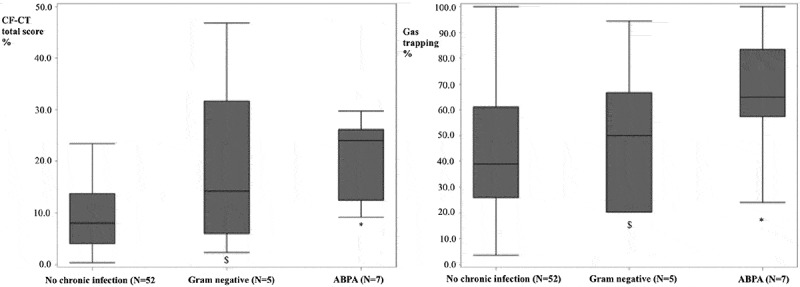
CF-CT total scores and percentage of gas trapping grouped according to infection status. (a) CF-CT total score, (b) gas trapping score. $Non-significant, *p<0.01, compared to the non-infected group (Mann–Whitney test). Data are presented as box and whiskers plots representing the 25th and 75th centiles and the range, respectively.